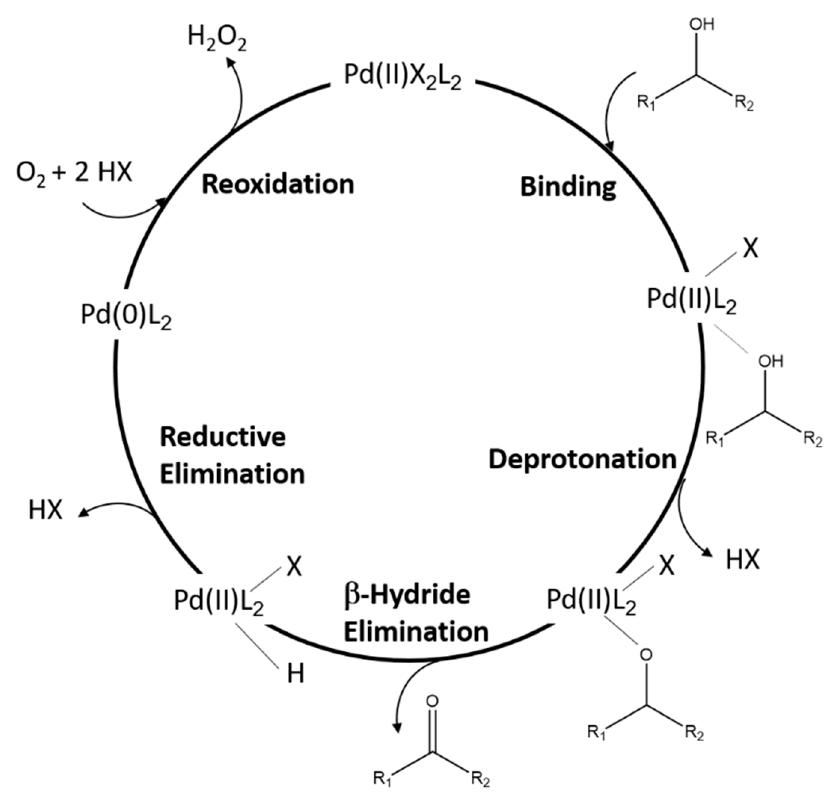
Figure 1. Mechanism of alcohol reduction of Pd(II) to Pd(0).